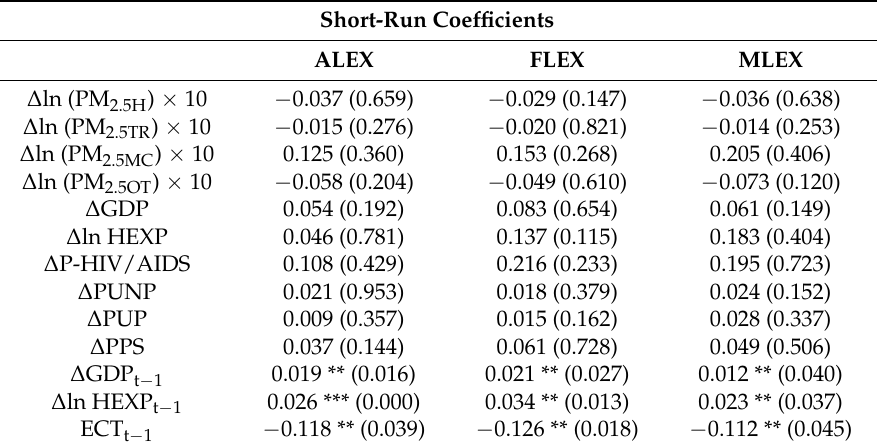
Table 5. Estimates of short-run coefficients for aggregate life expectancy